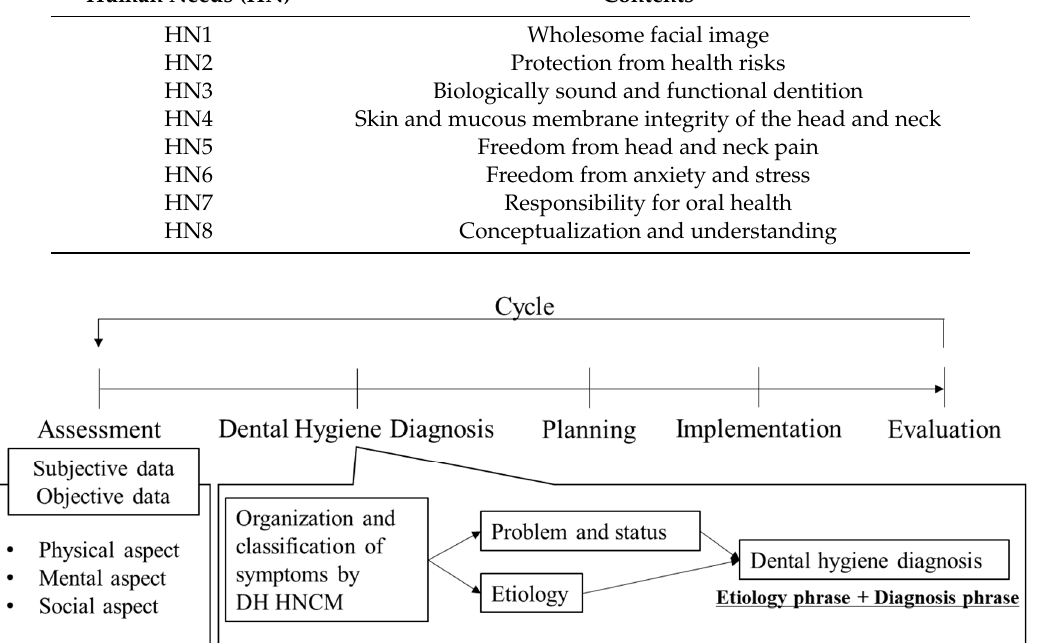
Figure 1. The flow of dental hygiene assessment and dental hygiene diagnosis in the dental hygiene process of care.